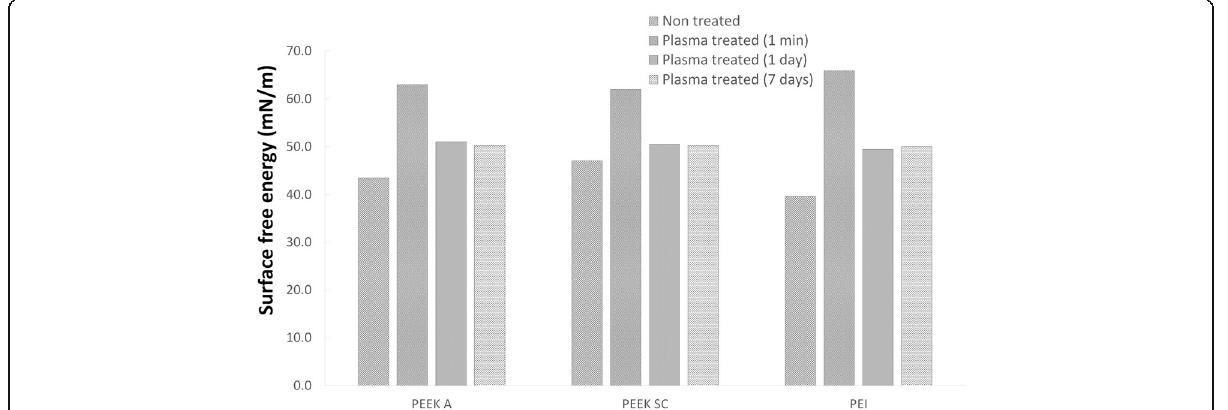
Fig. 9 Surface free energy depending on waiting time after plasma treatment